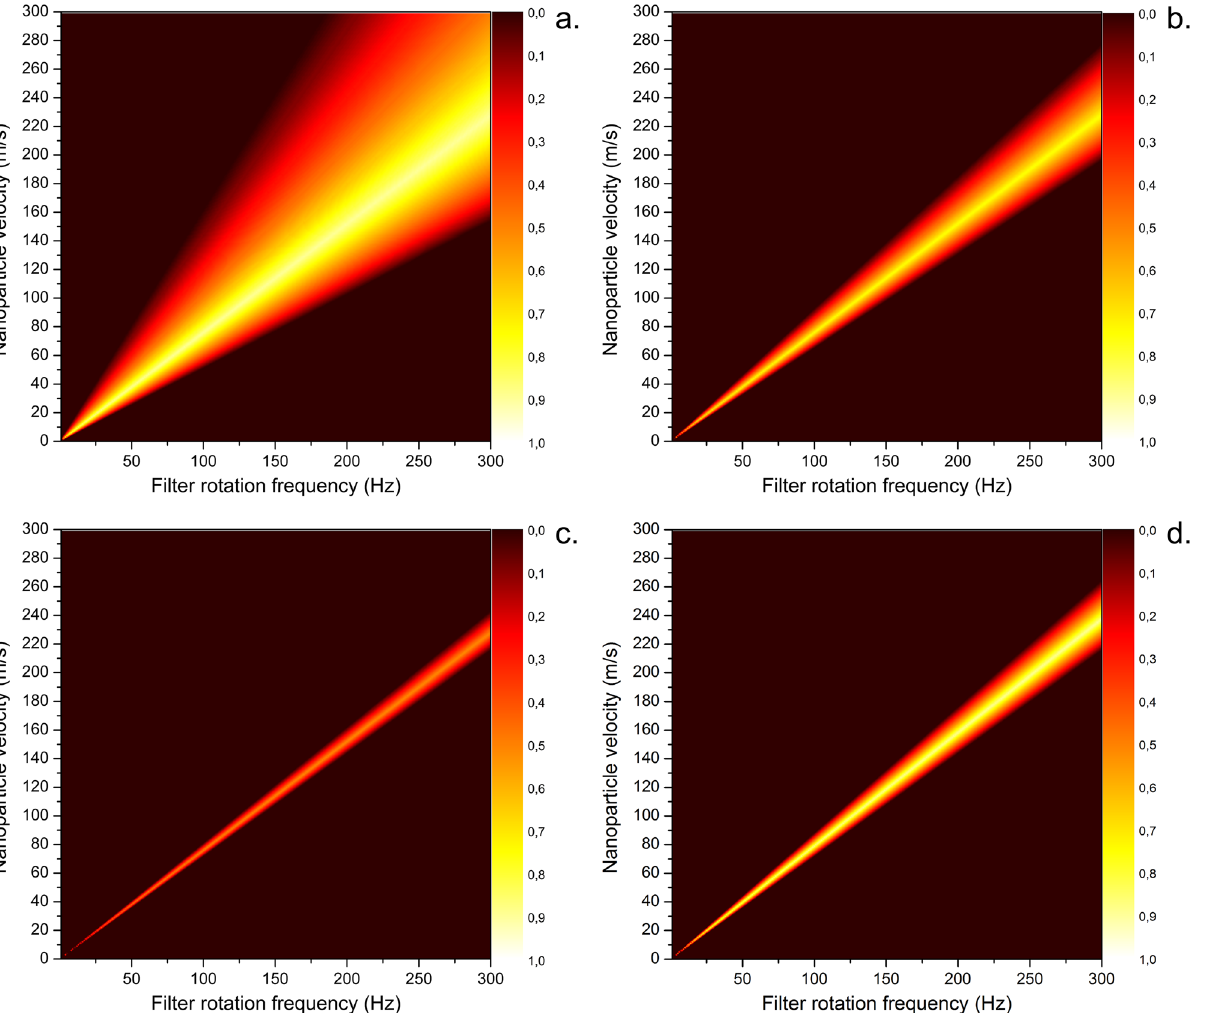
Figure 4. Calculated transmission signal maps for input nanoparticle velocities in the form of delta-functions, relative angle of the disks 9°, the distance of the disks 19 mm, disk thickness 1 mm and angular width of the slit ( a ) 5°; ( b ) 2°; ( c ) 1°. The last map under letter ( d ) shows the transmission of a helical rotor with a relative angle of the slit between the inlet and outlet of the slit again 9°, slit angular width 1° and thickness of the rotor 20 mm. The print resolution for the helical rotor (thickness of each subsequent incremental disk) is 0.2